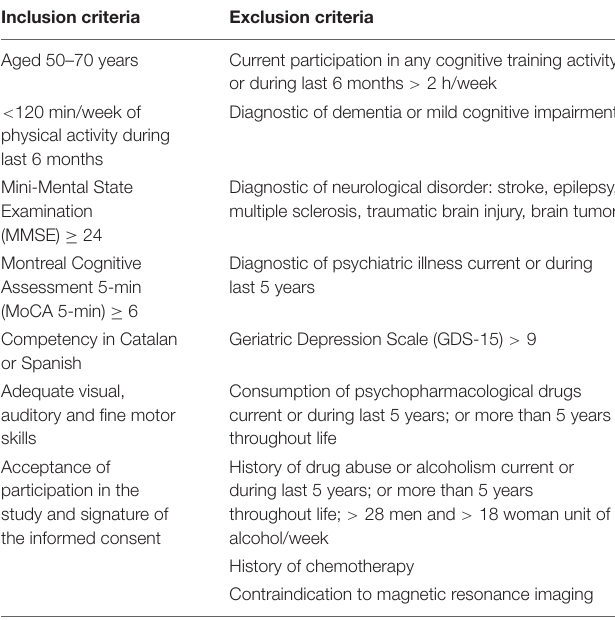
TABLE 1 | Inclusion and exclusion criteria for Projecte